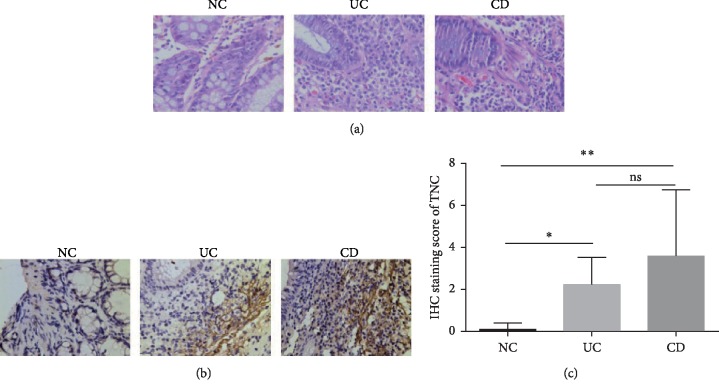
Increased expression of TNC in intestine of patients with UC and CD. (a) Representative H&E images of NCs (n = 7), UC (n = 8), and CD (n = 10) (original magnification, ×400). (b) Representative IHC images of TNC from NCs (n = 7), UC (n = 8), and CD (n = 10) (distal colon) (original magnification, ×400). (c) Comparison of IHC staining score among groups. ∗P < 0.05 and ∗∗P < 0.01. UC, ulcerative colitis; CD, Crohn's disease; NCs, normal controls.